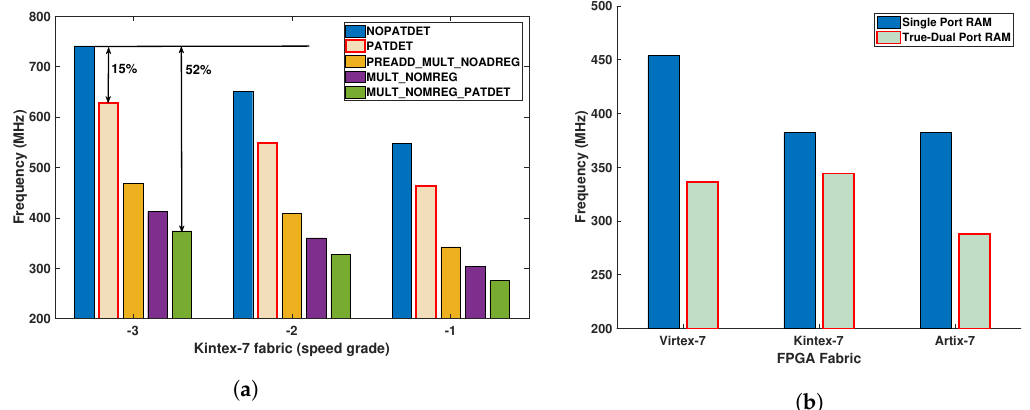
Figure 4. ( a ) Impact of DSP48E1 configurations on maximum achievable clock frequency using different speed grades using Kintex-7 FPGAs for fully pipelined with no (NOPATDET) and with (PATDET) PATtern DETector, then multiply with no MREG (MULT_NOMREG) and pattern detector (MULT_NOMREG_PATDET) and a Multiply, pre-adder, no ADREG (PREADD_MULT_NOADREG) ( b ) Impact of BRAM configurations on the maximum achievable clock frequency of Artix-7, Kintex-7 and Virtex-7 FPGAs for single and true-dual port RAM configurations. Table 2. Computing resources (DSP48E1) and BRAM memory resources for a range of Xilinx